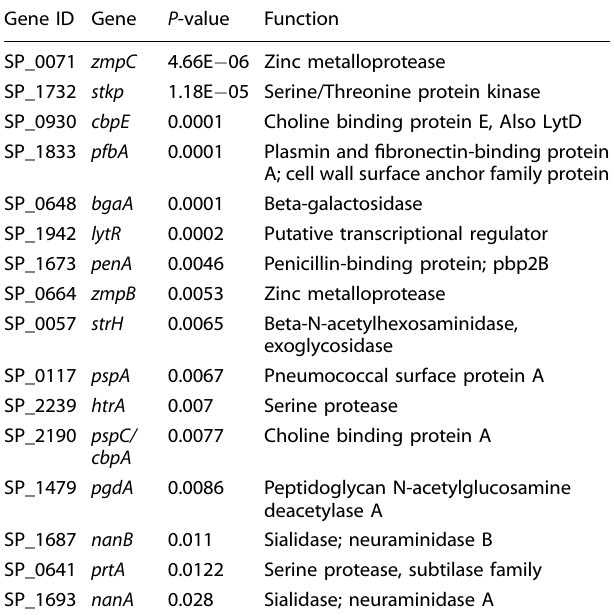
Table 1. Antibody-binding targets among the TnSeq-identi fi ed genes affecting carriage.